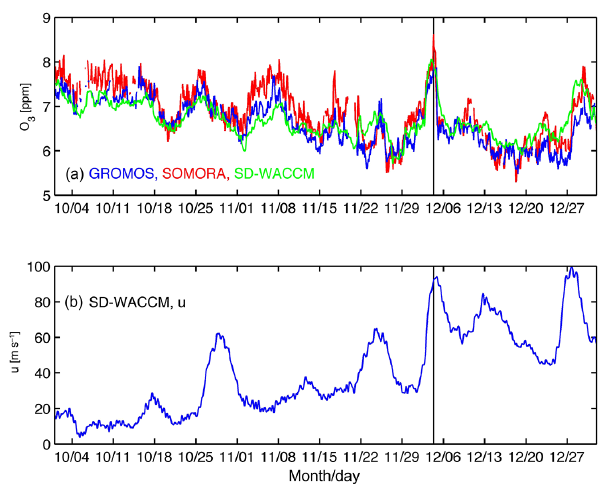
Figure 2. Left-hand side: vertical ozone profiles at Bern (or close to Bern) before the streamer arrival on 1 December 2015 12:00 UT (dashed line) and at the streamer arrival on 4 December 2015 12:00 UT. The GROMOS observations are indicated by the blue lines, the SD-WACCM results are given by the red lines, and Aura/MLS is shown by the green lines. Right-hand side: difference between the ozone profiles from 4 and 1 December 2015. The relative uncertain- ties of GROMOS, SOMORA and Aura/MLS are about